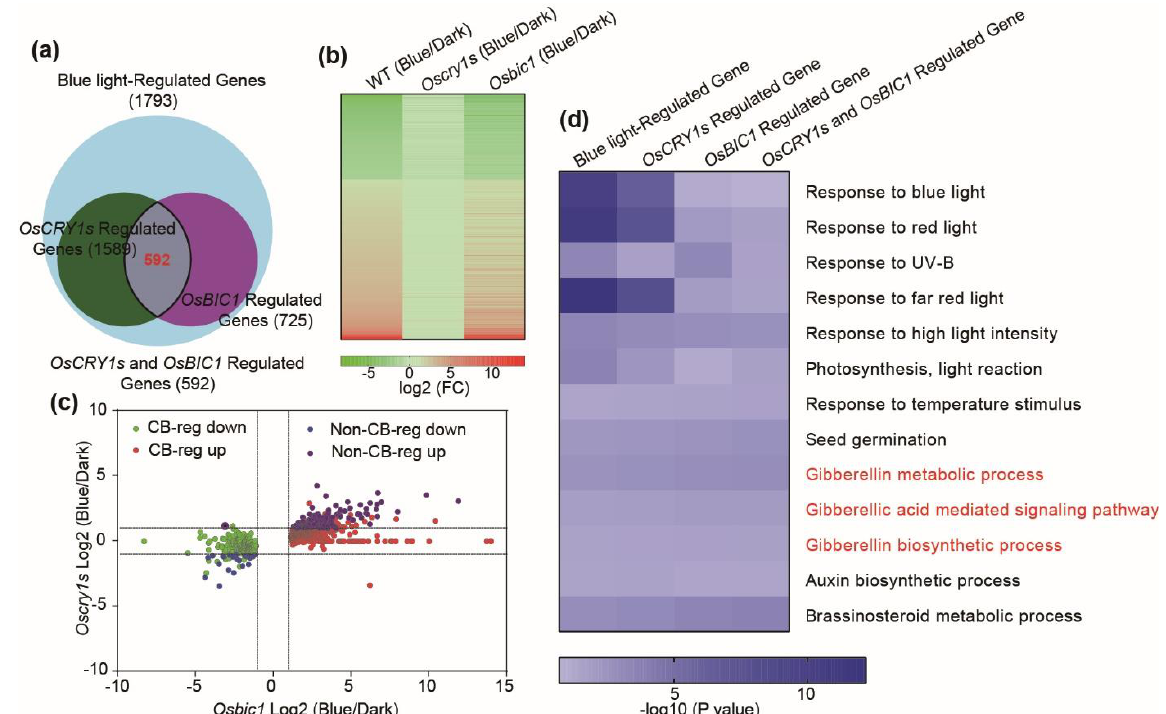
Figure 4. OsBIC1 and OsCRY1s regulated similar transcriptome changes under blue light conditions. ( a ) Venn diagram depicting the overlapping profiles among blue light-regulated, OsCRY1s -regulated, OsBIC1 -regulated, and OsCRY1s and OsBIC1 -regulated genes determined by RNA-seq. Blue light-regulated genes showed a factor of > 2 change of mRNA (Fold Change (FC) > 2, p value < 0.01, False Discovery Rate (FDR) < 0.01) in WT-Blue when compared with WT-Dark. The blue light-regulated genes that showed FC < 2 or p > 0.01 in Oscry1s -Blue in comparison to Oscry1s -Dark were defined as OsCRY1s -regulated genes. The blue light-regulated genes that showed FC > 2 and p < 0.01 in Osbic1 -Blue in comparison to Osbic1 -Dark were defined as OsBIC1 -regulated genes. The overlapping profiles among blue light-regulated, OsCRY1s -regulated, and OsBIC1 -regulated genes were defined as CB-reg genes. ( b ) Hierarchical clustering analysis of the CB-reg genes in blue light-regulated, OsCRY1s -regulated, and OsBIC1 -regulated genes profiles. Green indicated down-regulation genes, and red was used to indicate up-regulation genes. ( c ) Scatter plots show the correlation between the Osbic1 blue/dark log2 (FC) and Oscry1s blue/dark log2 (FC). The dashed lines indicated log2 (FC) = 1 and −1. ( d ) Enriched gene ontology functional categories in the blue light-regulated,